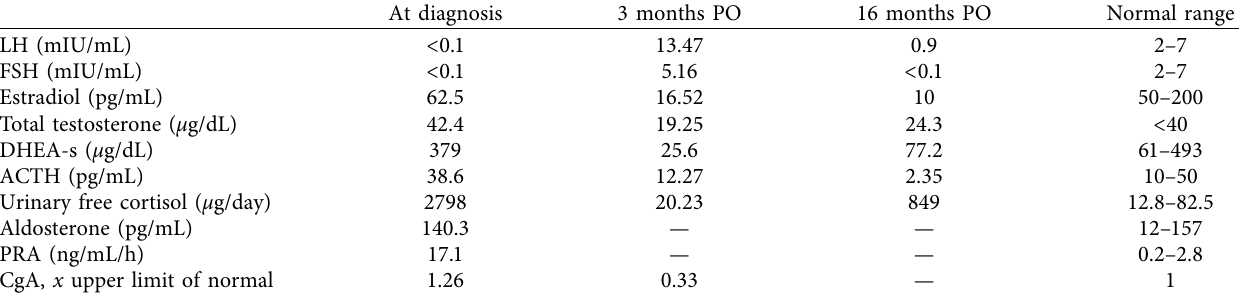
Table 1: Hormonal evaluation at diagnosis and at 3 and 16 months after right adrenalectomy.